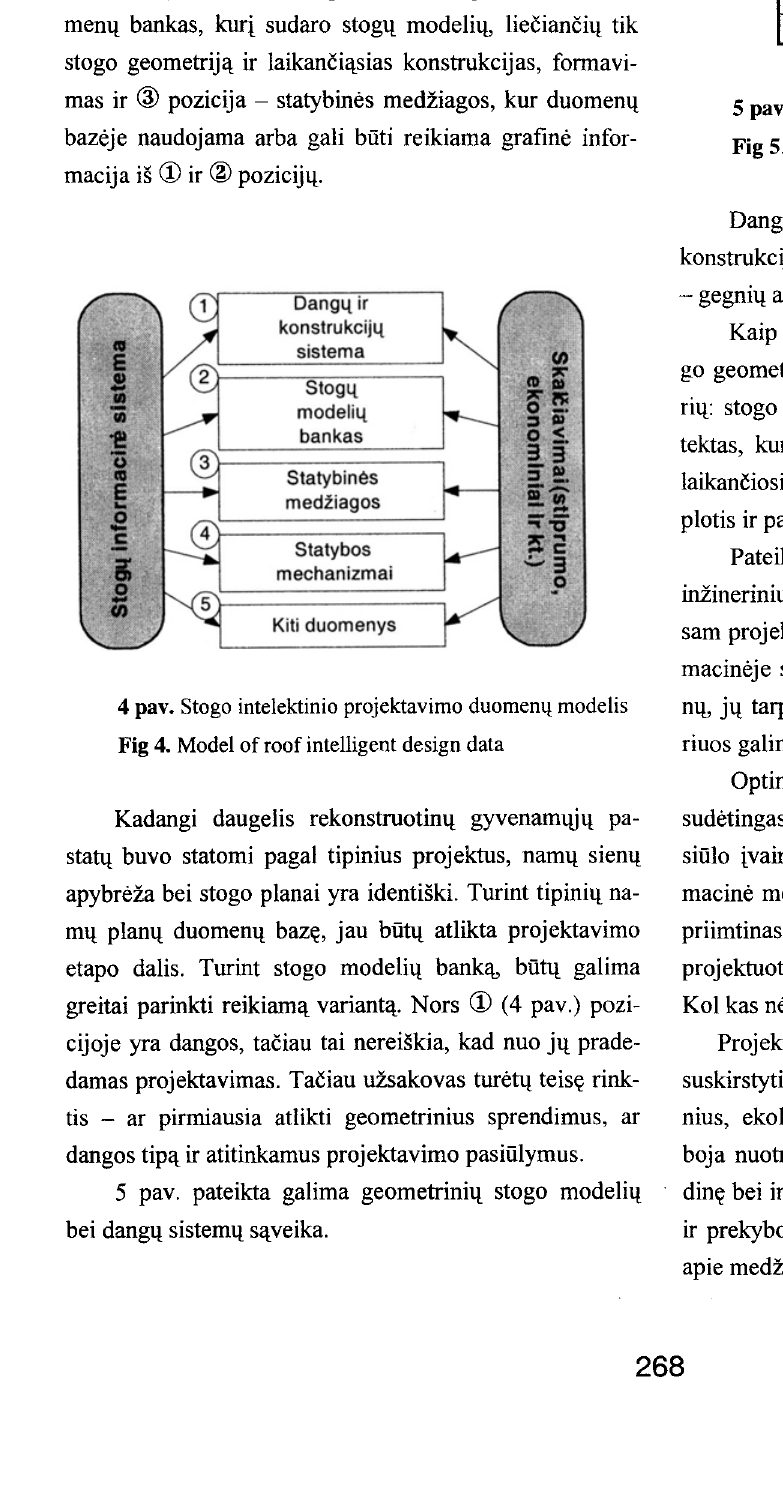
Fig 5. Model of interaction of roof geometry and